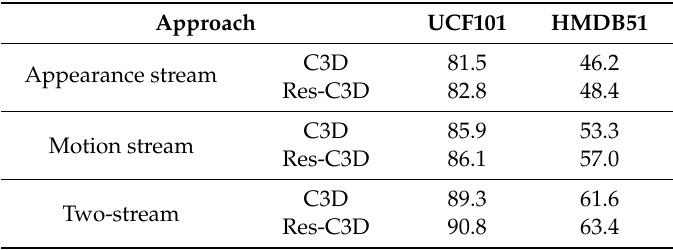
Table 1. Comparison of classification accuracies (%) for the two-stream encoder constructed with C3D and the proposed Res-C3D on UCF101 and